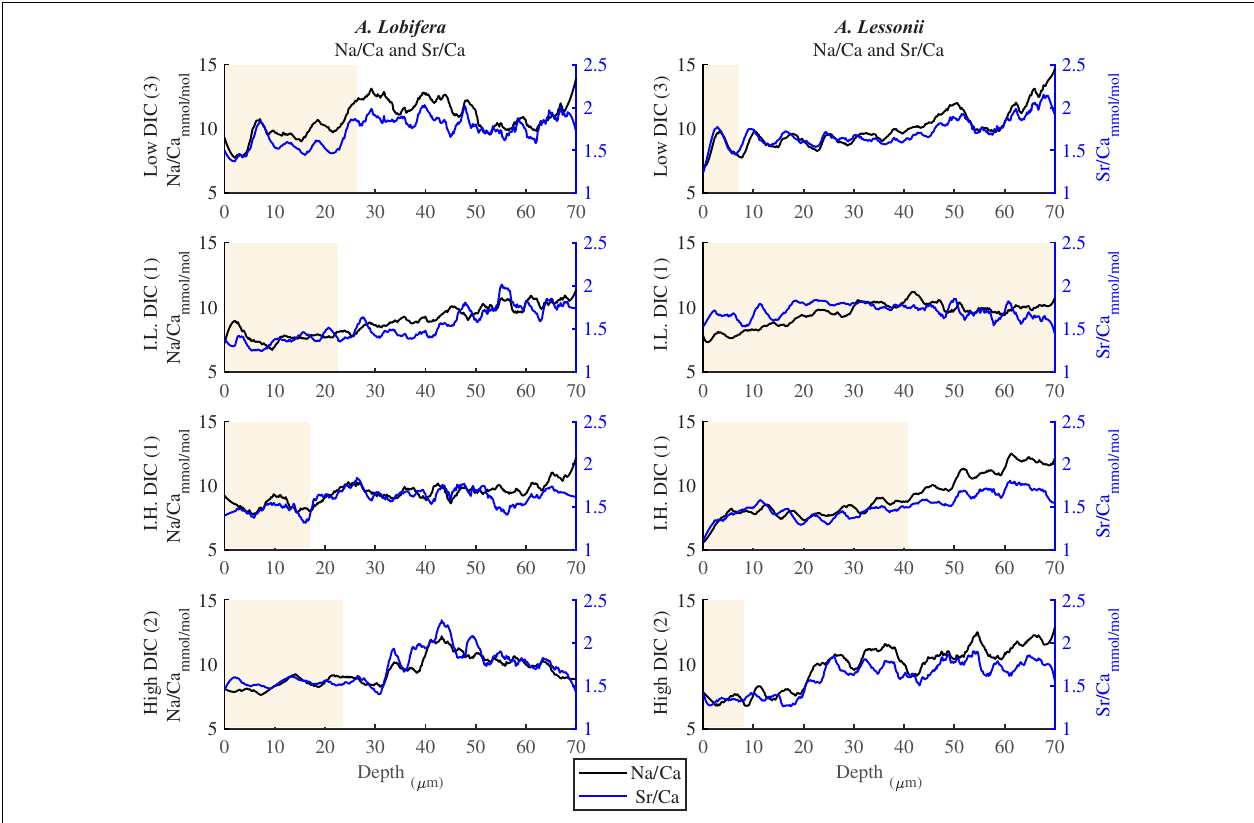
FIGURE 6 | Na/Ca and Sr/Ca ratios in the knob profile of A. lessonii and A. lobifera for one selected specimen for each DIC treatments (all the data are given in the Supplementary Material ). It should be noted that these two elements show less similarity to the Mg-K-U cycles shown in Figures 4 , 5 . On the whole, however, the number of cycles (i.e., the frequency) is similar to the those of Mg. The DIC treatment did not affect the elemental cycles.